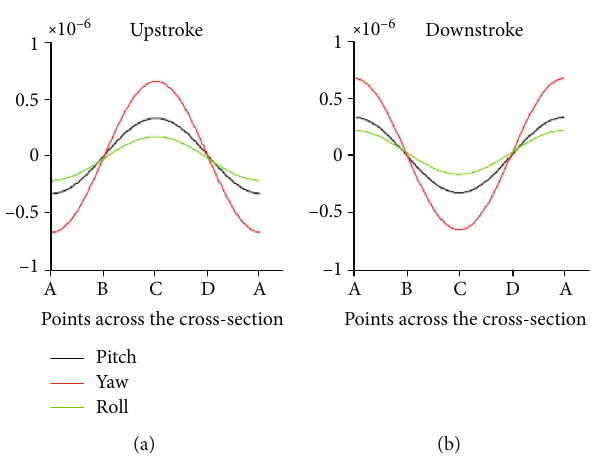
Figure 9: Stress distribution due to pitch, yaw, and roll rotations across the cross-section of the haltere base during the upstroke and downstroke